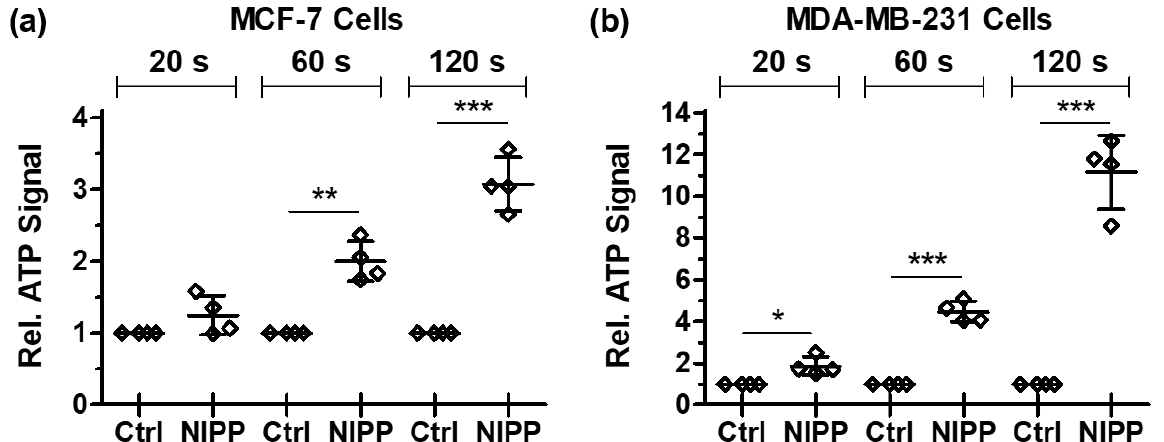
Figure 6. ATP release assay. Breast cancer cells MCF-7 ( a ) and MDA-MB-231 ( b ) were treated with non-invasive physical plasma (NIPP) for 20, 60, and 120 s and incubated for 10 min at room temperature. Control cells were treated with argon for appropriate times (Ctrl). Subsequently, cell-free supernatant was measured with CellTiter Glo 2.0 ATP reagent (infinite M200 Pro microplate reader) to determine extracellular ATP. ATP concentrations were expressed as relative signal normalized to controls. The results are displayed as mean ± standard deviation ( p ≤ 0.05 *; p ≤ 0.01 **; p ≤ 0.001 ***).